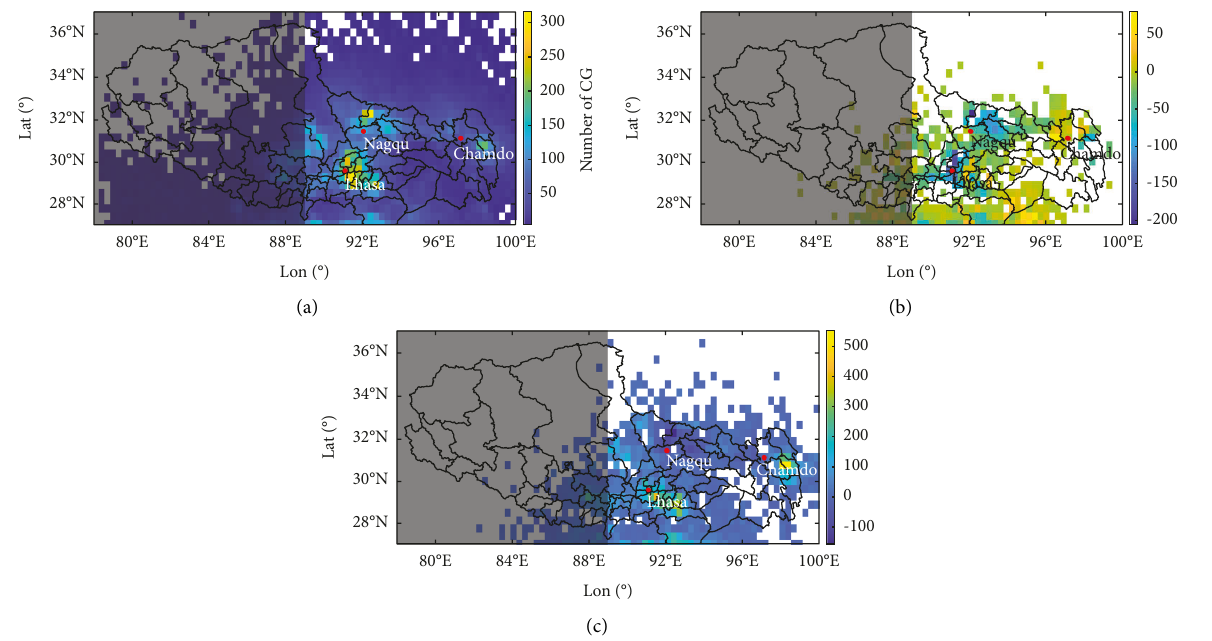
Figure 3: (a) Average distribution of CG lightning during 2009–2018. (b) Difference between the lowest year of CG lightning (2009) and the 10-year average. (c) Difference between the highest year of CG lightning (2014) and the 10-year average. The area of 0.1 ° × 0.1 ° is taken as a unit area, and the area with less than 2 times/year is omitted from the